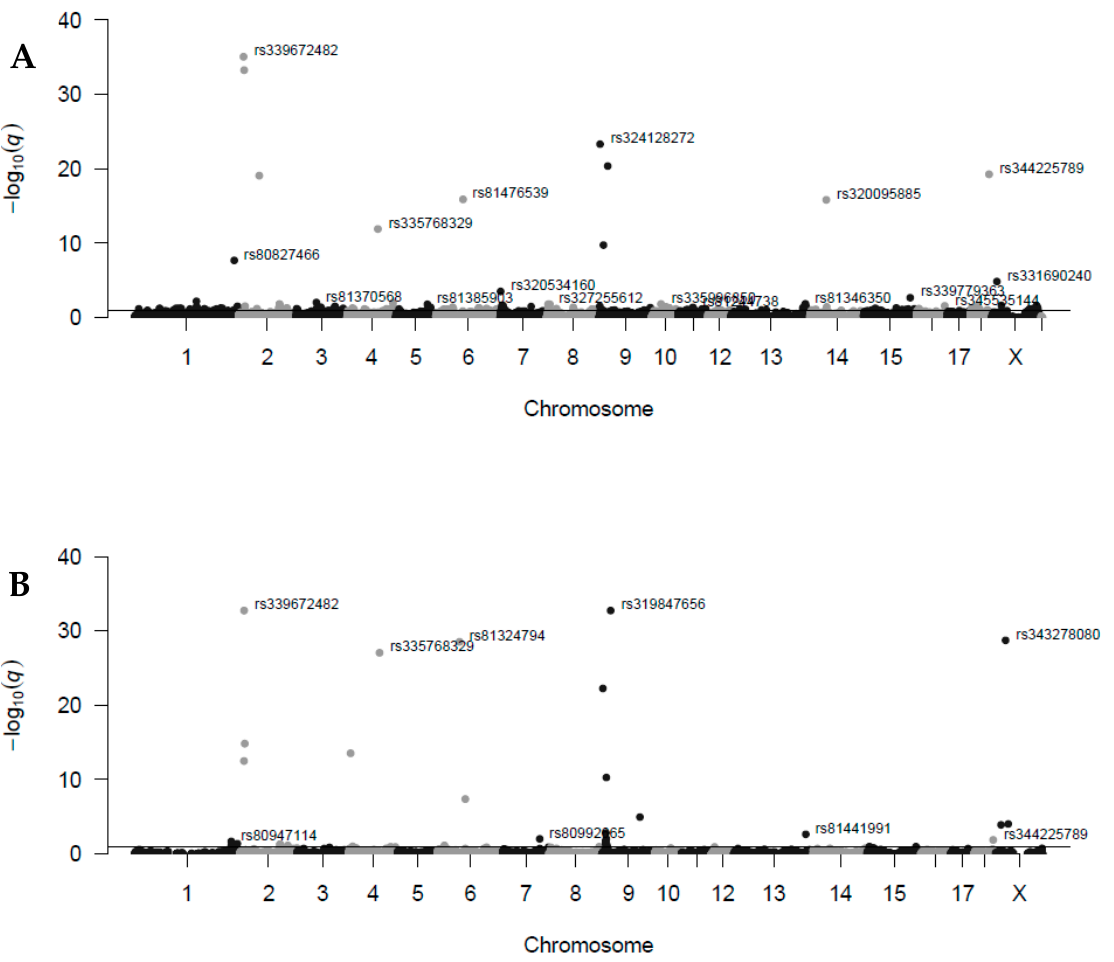
Figure 1. Distribution of maternal transmission ratio distortion loci (TRDLs) in families of Entrepelado ( A ) and Retinto ( B ) varieties across pig chromosomes. The top hit marker ID on each chromosome below the q -value threshold (0.05, corrected p -value; line) is annotated.